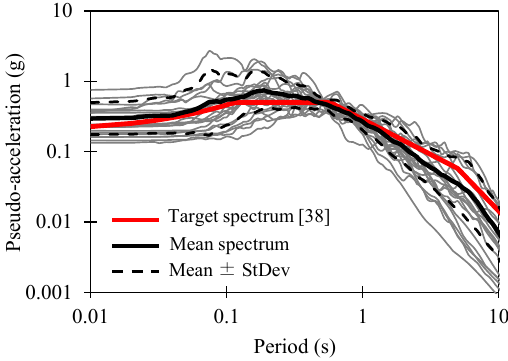
Figure 12. Response spectrum of selected ground motions.